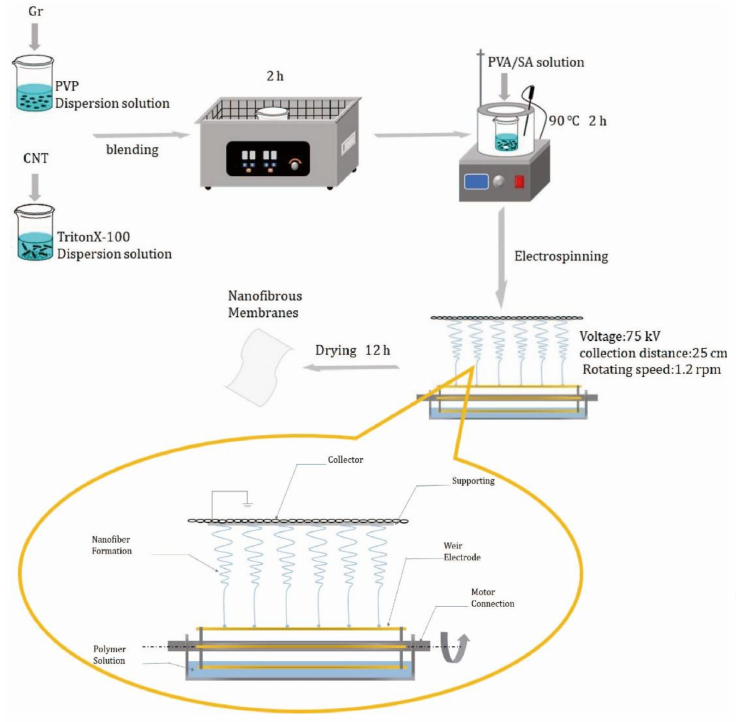
Figure 1. Process of the preparation of linear electrospinning nanofiber